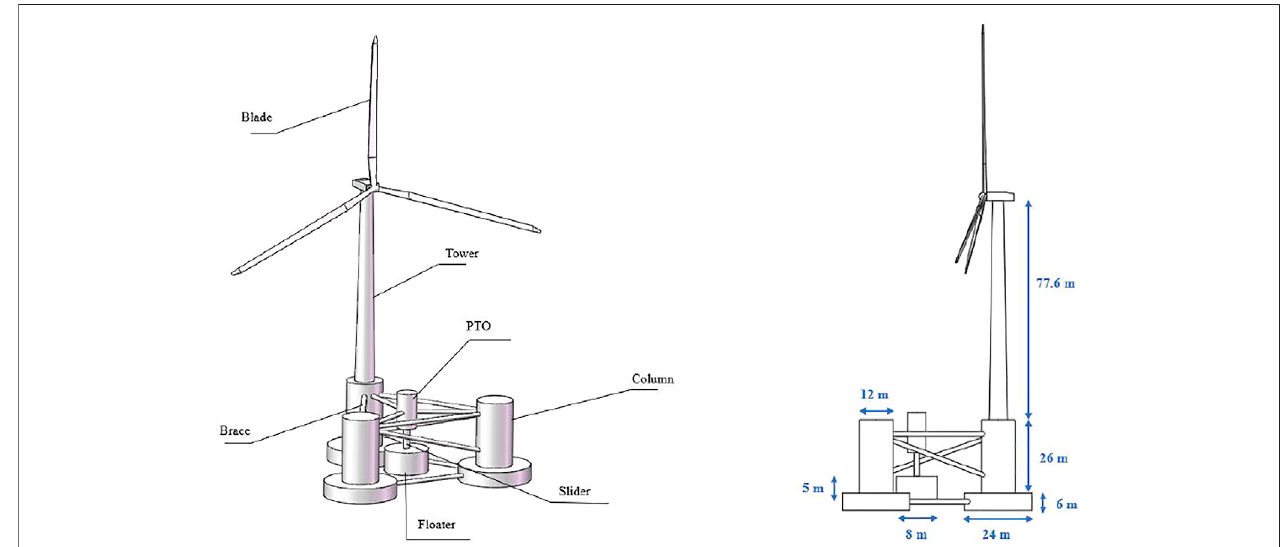
FIGURE 1 | Integrated fl oating wind and wave integrated power generation platform.